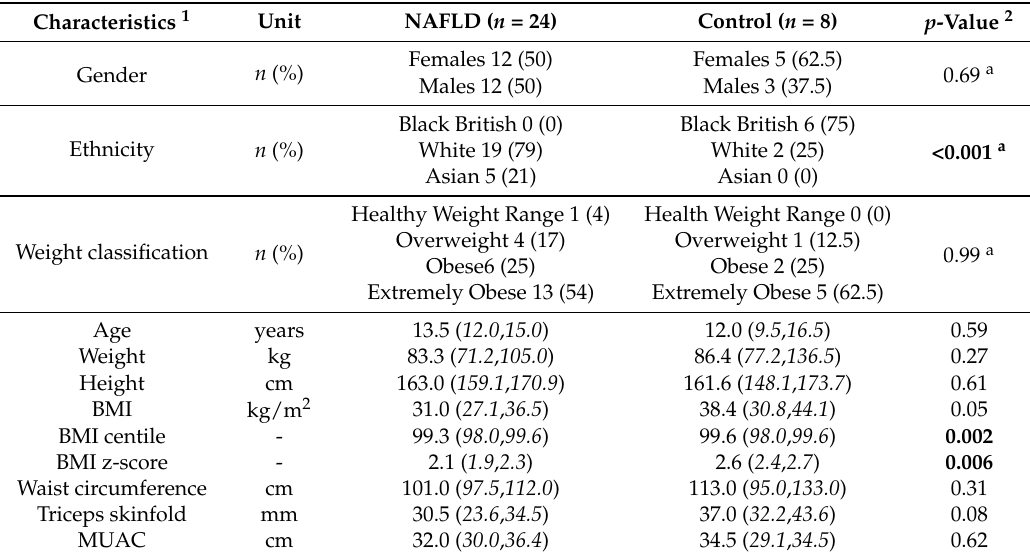
Figure 1. Participant flow diagram for the case-control study. Table 1. Population characteristics of NAFLD and obese control groups.